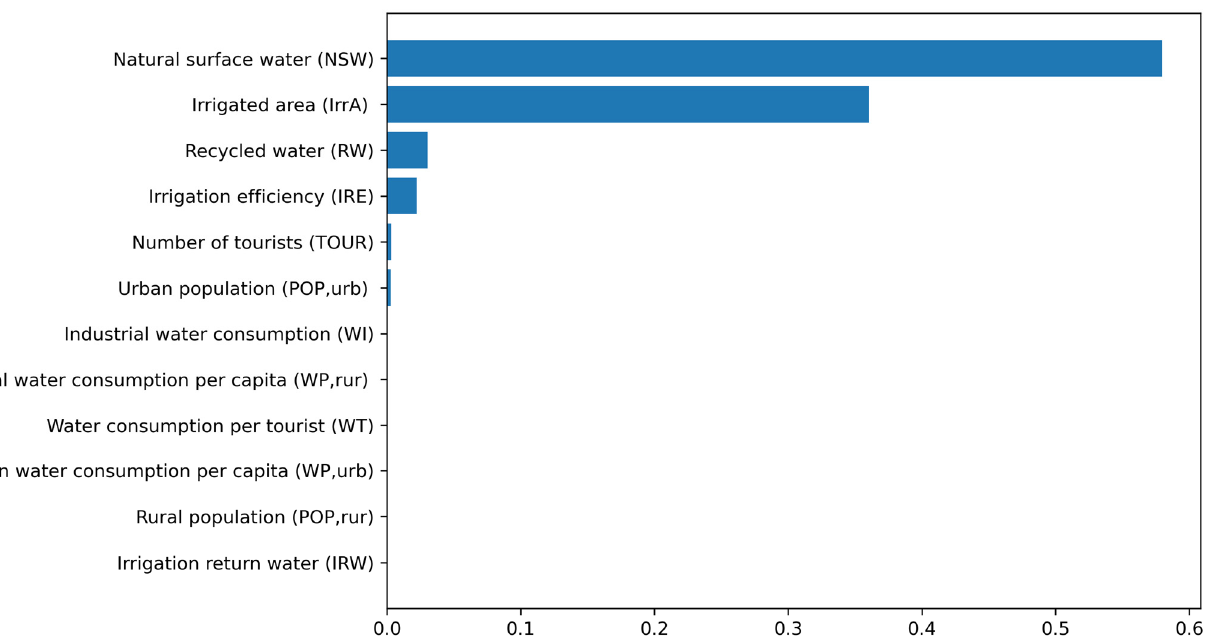
Figure 8. Correlation matrix of the System Dynamics model parameters.